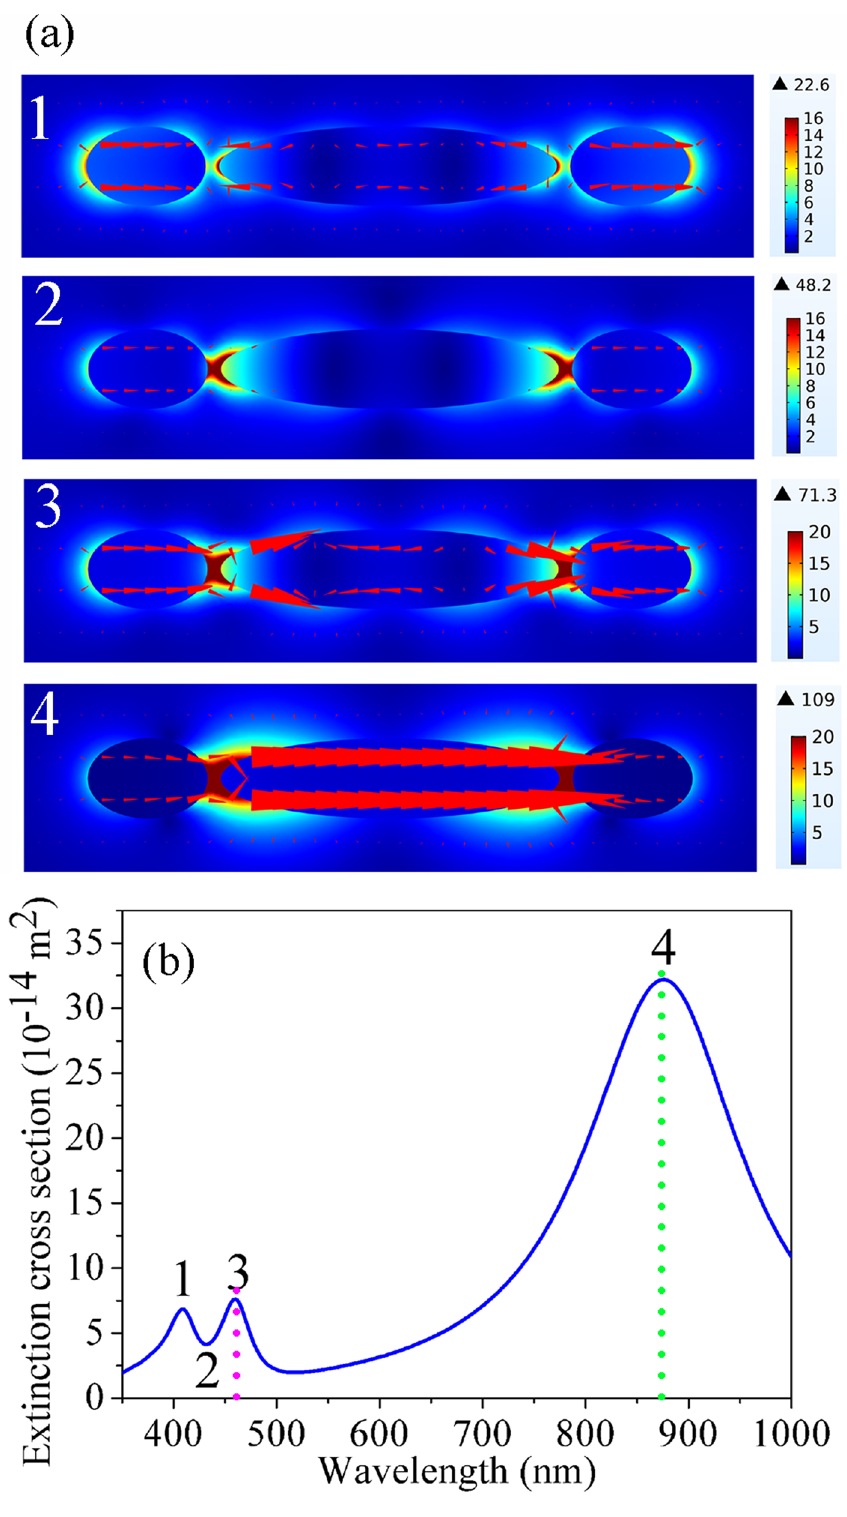
Figure 4. ( a ) Electric field and current flow distributions of the silver nanorice trimer at the positions 1, 2, 3 and 4 in ( b ), respectively. ( b ) Extinction spectrum of the silver nanorice trimer (L 1 = 254 nm, L 2 = 90 nm, D = 60 nm, g = 10 nm) for enhancing the 997 cm −1 mode with 876 nm excitation light. Here, the mode 4 and mode 3 resonance are matched to the excitation light (green dotted line, 876 nm) and second-order Stokes (pink dotted line, 458 nm) wave,